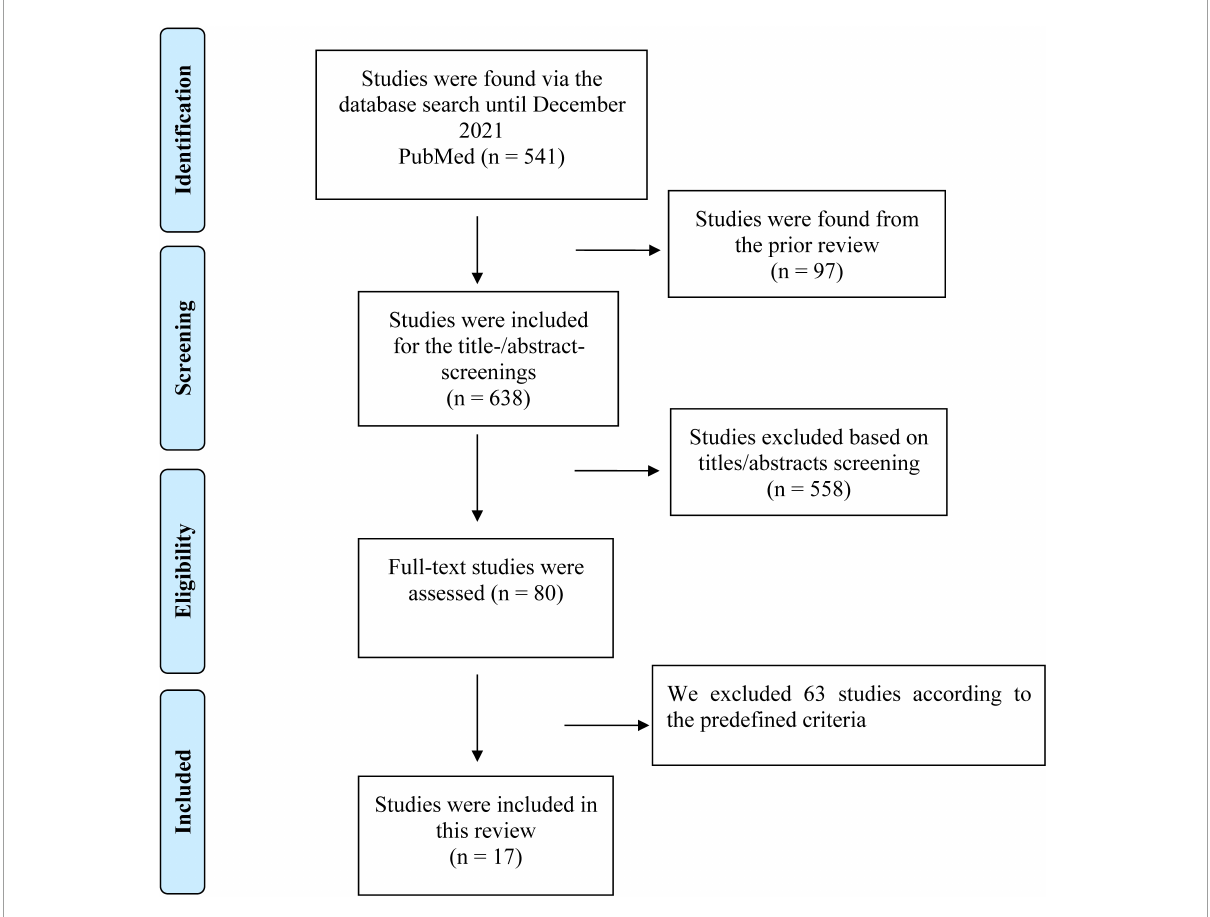
FIGURE1 Flowchart of document retrieval and screening process of this